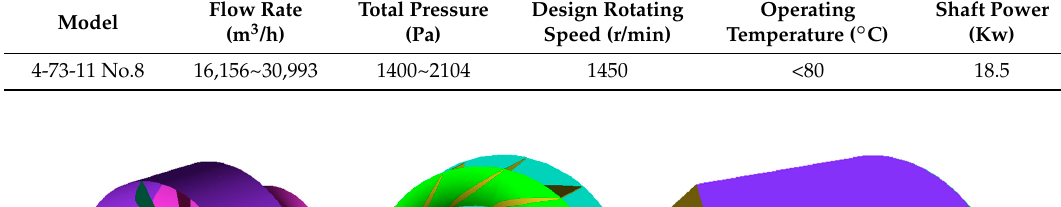
Figure 2. Computation model of CF: ( a ) leading-blade (LB); ( b ) impeller; and ( c ) volute.